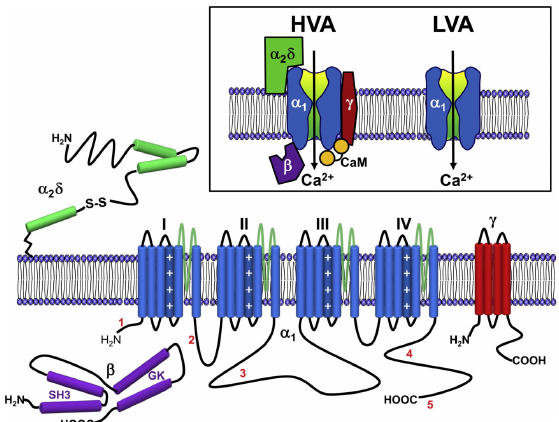
Figure 4. Representation of the membrane topology and secondary structure of HVA channels. In blue: the common structure of HVA and LVA channels, with their four VSD (I, II, III, and IV). The dark blue cylinder in each VSD is the charged S4 helix. The single blue cylinder in each VSD is the S6 helix that forms the pore domain. In green, purple, and red: the other subunits of HVA channel. The lengths of lines correspond approximately to the lengths of the polypeptide segments represented. Inbox at top: comparative representation of the structure of HVA and LVA calcium channels ( α 1 ) and the subunits of HVA channels ( α 2 δ , β , and γ ). Taken from the journal Neuron , article “Neuronal Voltage-Gated Calcium Channels: Structure, Function, and Dysfunction”